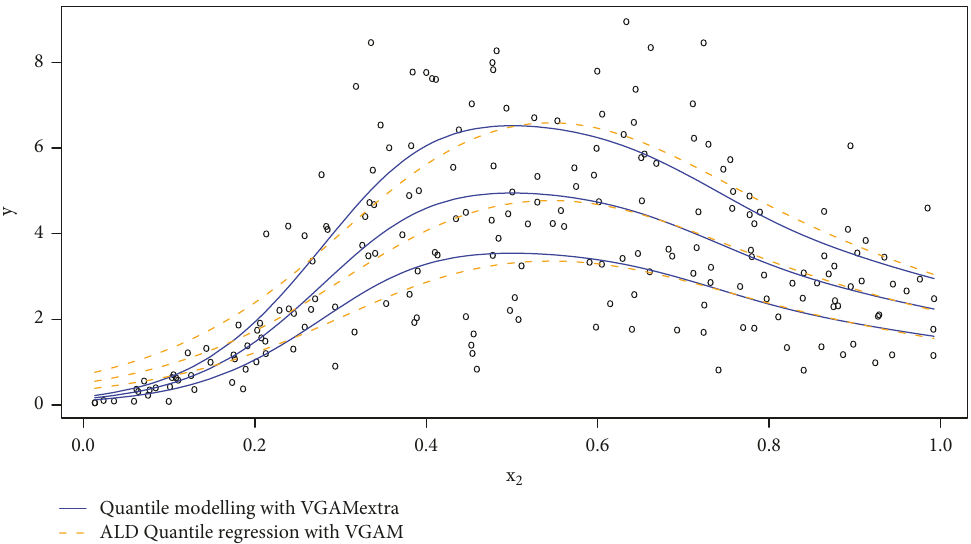
Figure 1: Simulated Maxwell data (21) including ( a ) the fitted quantile functions from fit.Qmodelling ( VGAMextra ) and ( b ) the fitted quantile curves from fit.Qregression ( VGAM ). The quantile curves in both cases derive from vector smoothing spline fits.